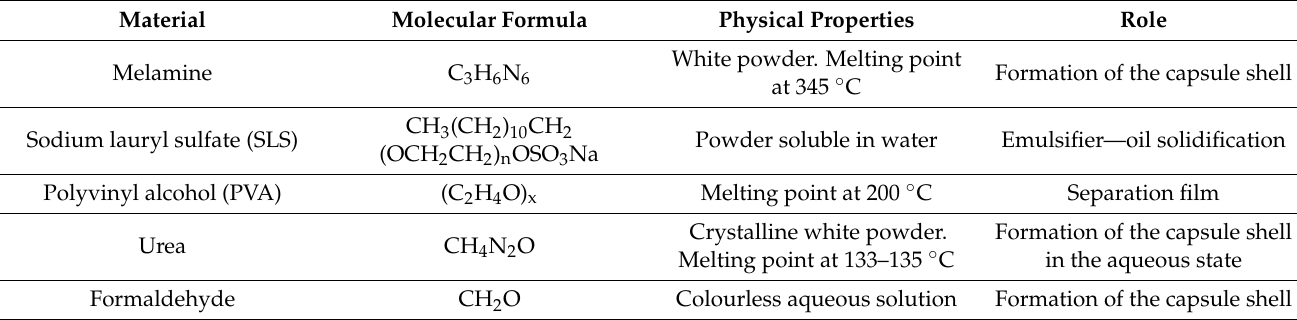
Table 2. Materials used in the synthetization of self-healing MUF-ENB